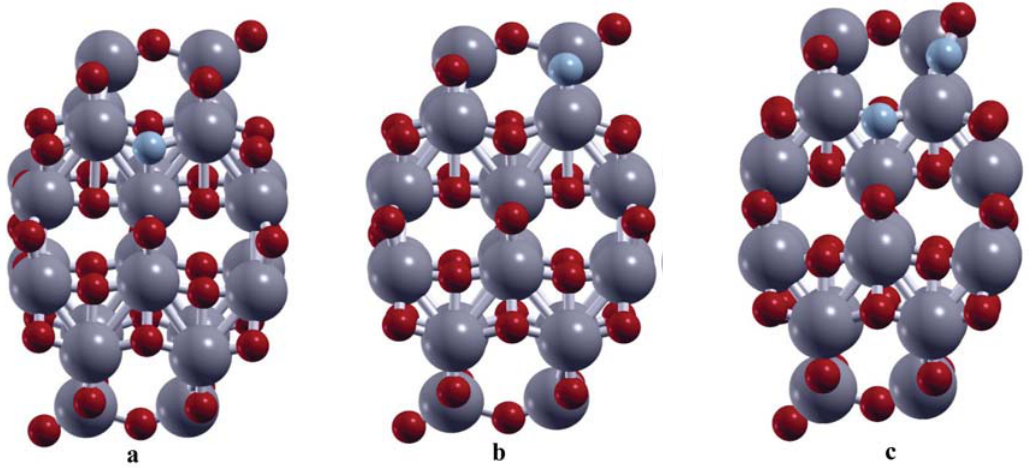
Figure 2. Optimized N-doped TiO tuted one. The larger gray spheres are Ti atoms and the small red and blue ones represent O and N atoms,